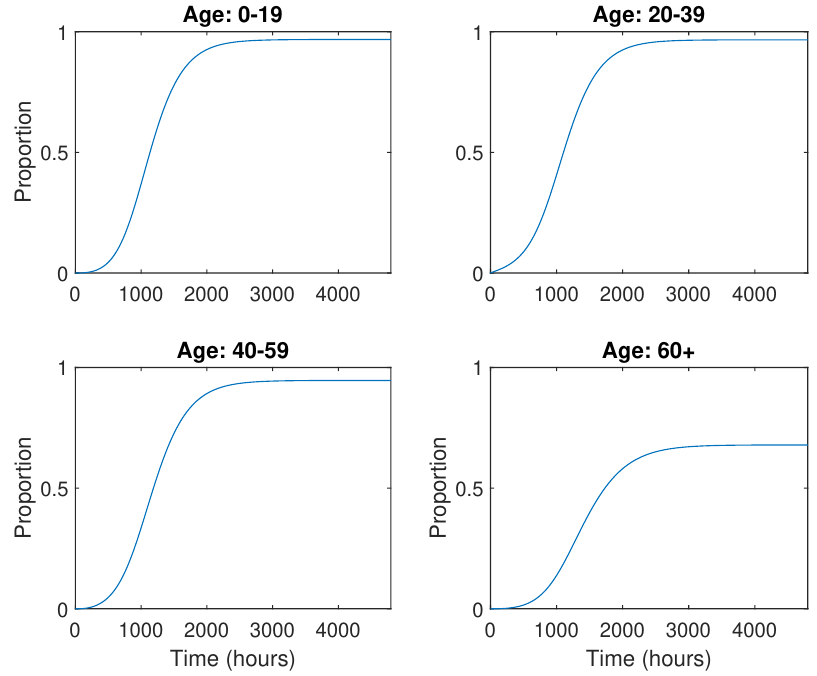
Figure 7. Total number of recovered by age group with HEPA filtration A = 18, q = 25.